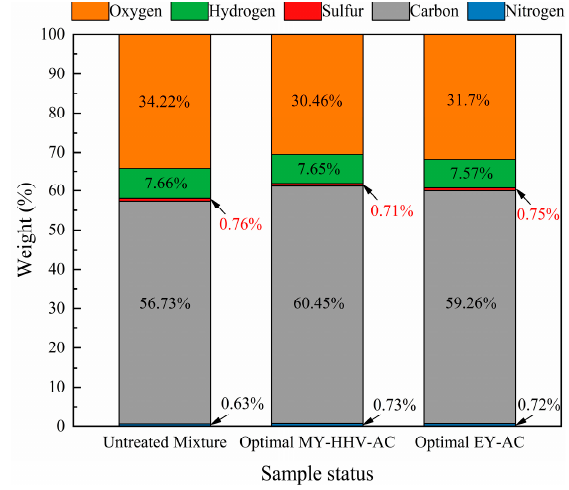
Figure 6. Compositions of raw and optimal samples.